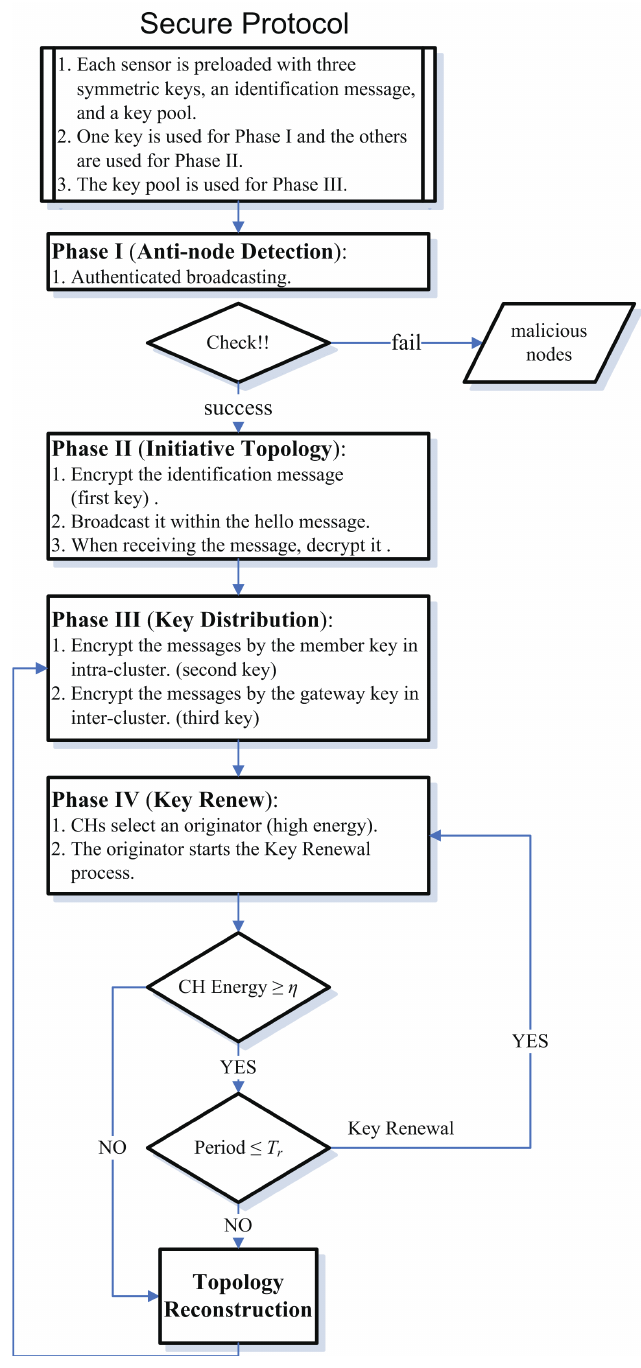
Figure 4. Secure distributed topology control for